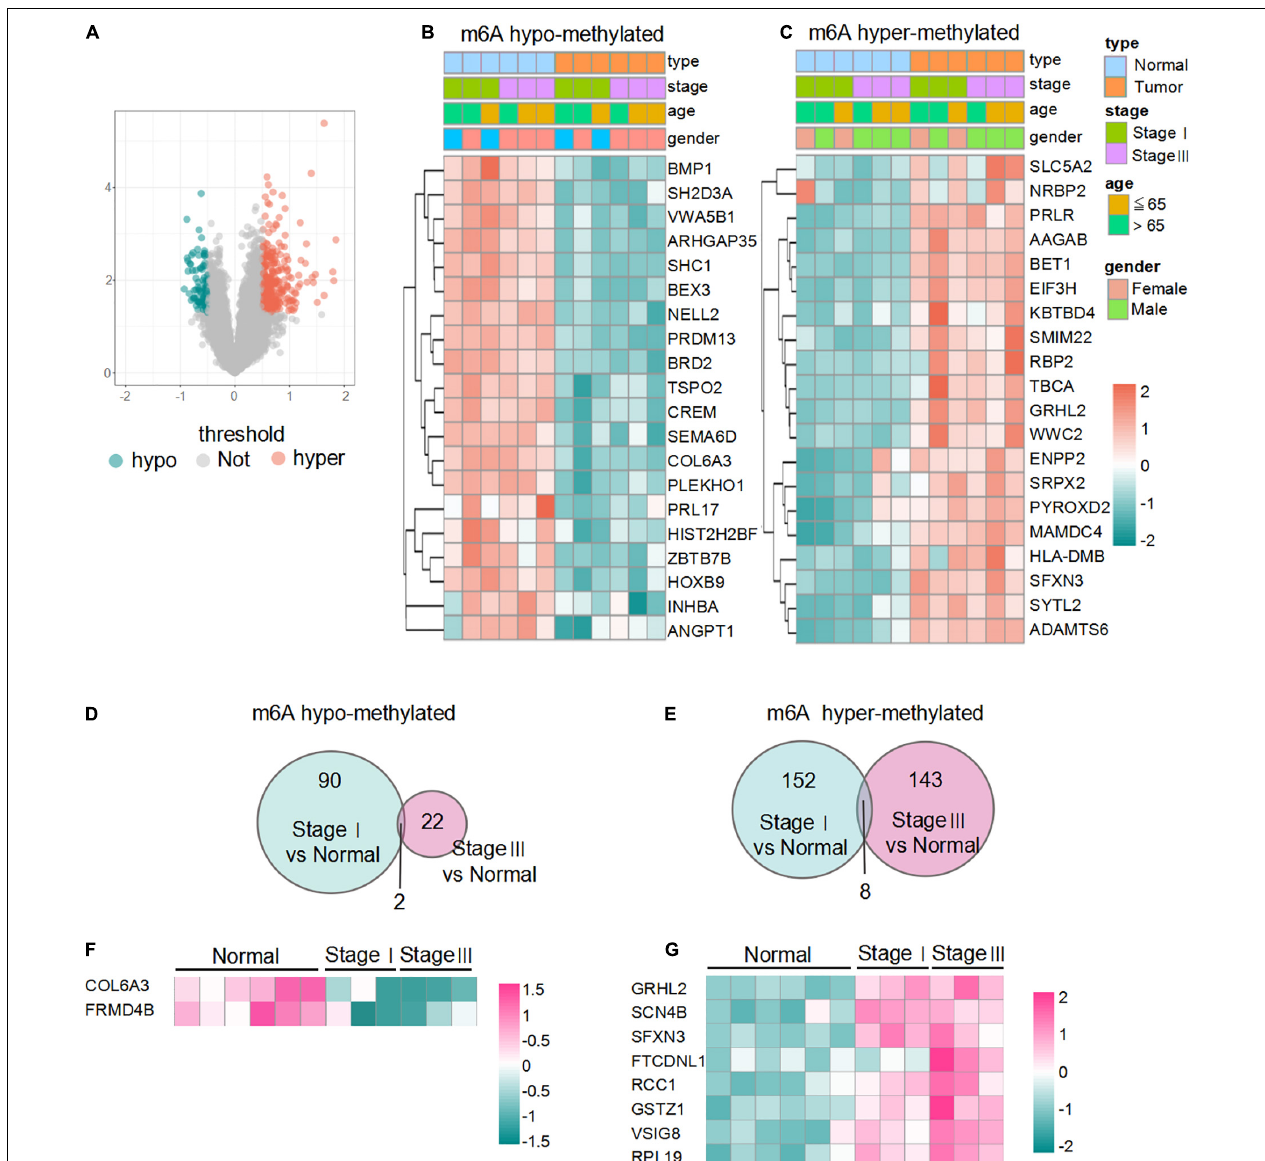
FIGURE 2 | Overview of differentially m6A-methylated mRNAs in LUAD. (A) Volcano plot of differentially m6A-modified mRNAs based on log2FC > 0.5 and p -value < 0.05. (B,C) Heatmaps of the top 20 m6A hypo- and hypermethylated mRNAs in LUAD. Data are shown in green (m6A hypomethylation) to red